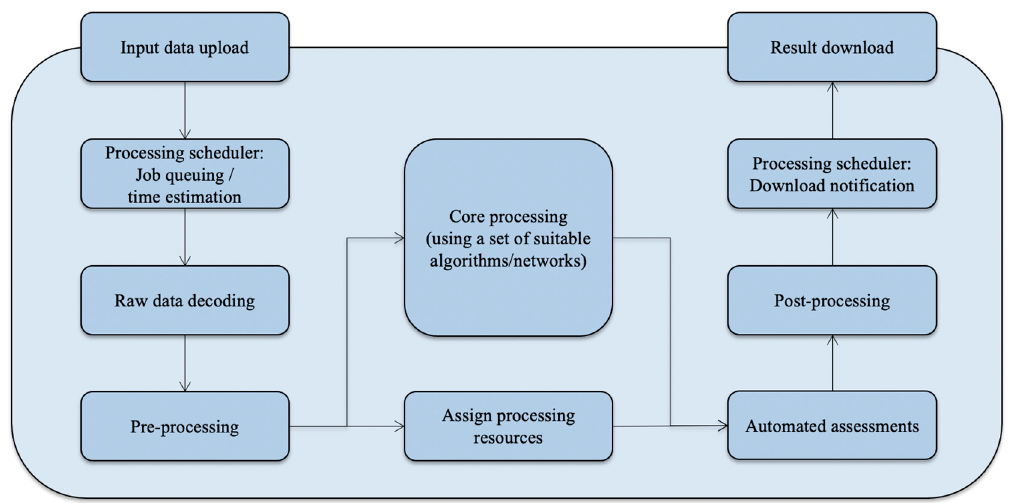
Figure 18. Proposed future streamlined SRR processing system based on automated SRR and quality assessments.